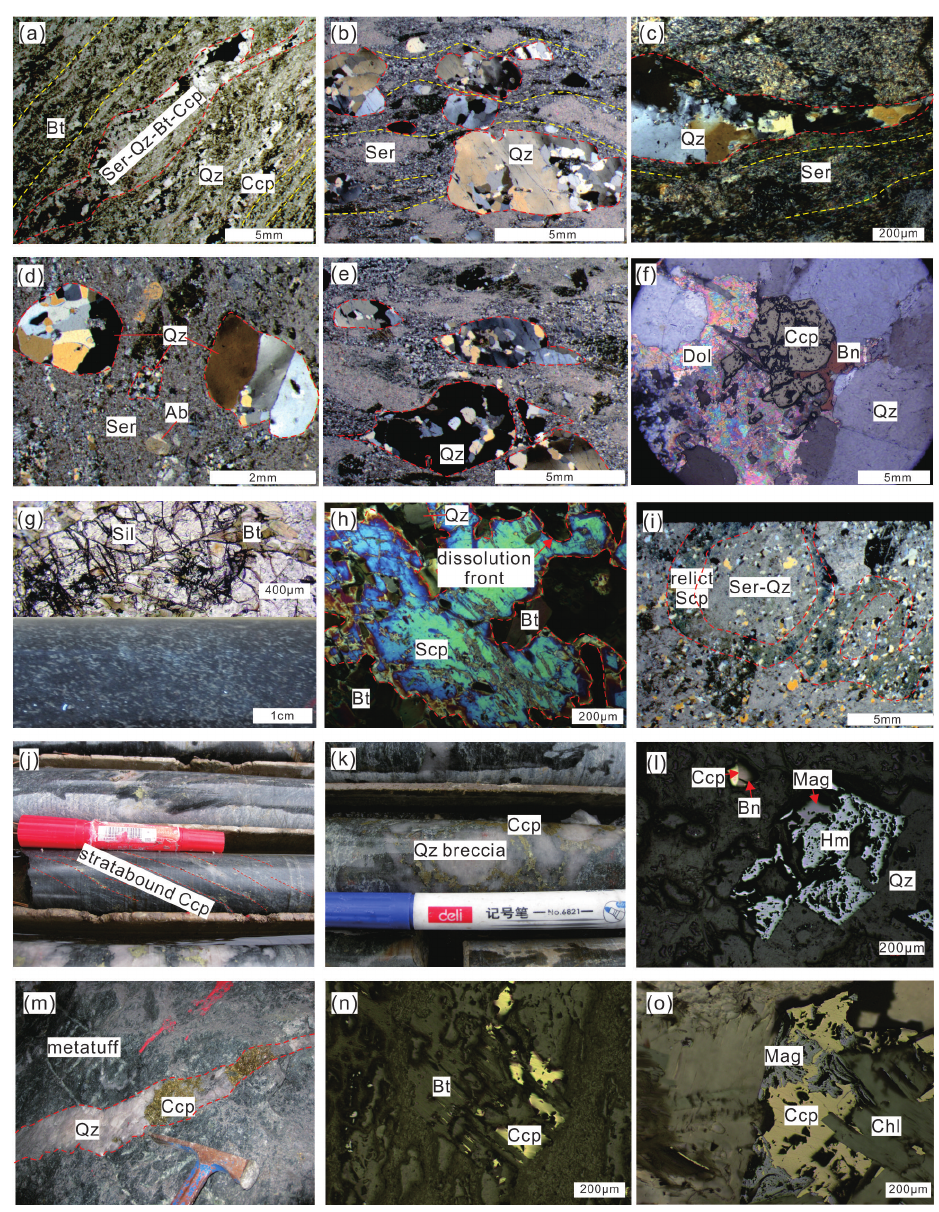
Figure 3. Petrographic and field photos of the Tongkuangyu copper deposit. ( a ) Mineral alignments in metatuff with biotite thin layers and sericite-quartz-biotite-chalcopyrite thick layers; ( b ) Mineral alignments in monzogranite porphyry with sericite layers and deformed quartz aggregates; ( c ) Mineral alignments of sericite and quartz-(albite) lenticulars; phenocrystic quartz in metatuff ( d ) and monzogranite porphyry ( e ) exhibits undulatory extinction and subgrain recrystallization; ( f ) Quartz from the hematite-quartz vein shows no sign of influence by ductile deformation; ( g ) Sillimanite and biotite in the mafic volcanic rocks; ( h , i ) Scapolite in the mica schist, which was dissolved by biotite, sericite, and quartz; ( j ) Layered chalcopyrite mineralization in metatuff; ( k , l ) Chalcopyrite-quartz veins in the metatuff; ( m ) Chalcopyrite and chlorite replacing preexisting biotite in metatuff under cross-polarized ( m ) and reflected light ( n ); ( o ) Chalcopyrite and chlorite replacing preexisting biotite in biotite schist. Ab: Albite; Bn: Bornite; Bt: Biotite; Ccp: Chalcopyrite; Dol: Dolomite; Hm: Hematite; Mag: Magnetite; Qz: Quartz; Scp: Scapolite; Ser: Sericite; Sil: